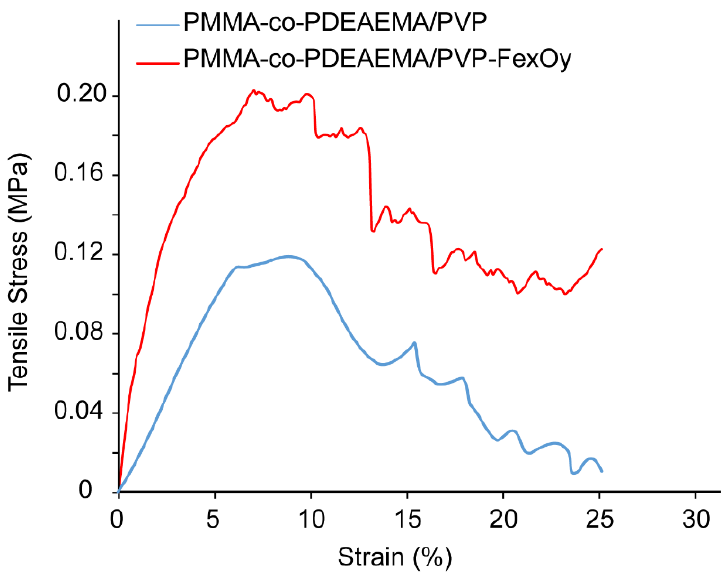
Figure 10. Stress – strain curves recorded under tensile conditions for the pristine membrane (blue) and the magnetically functionalized electrospun fibrous membrane (red). and the magnetically functionalized electrospun fibrous membrane